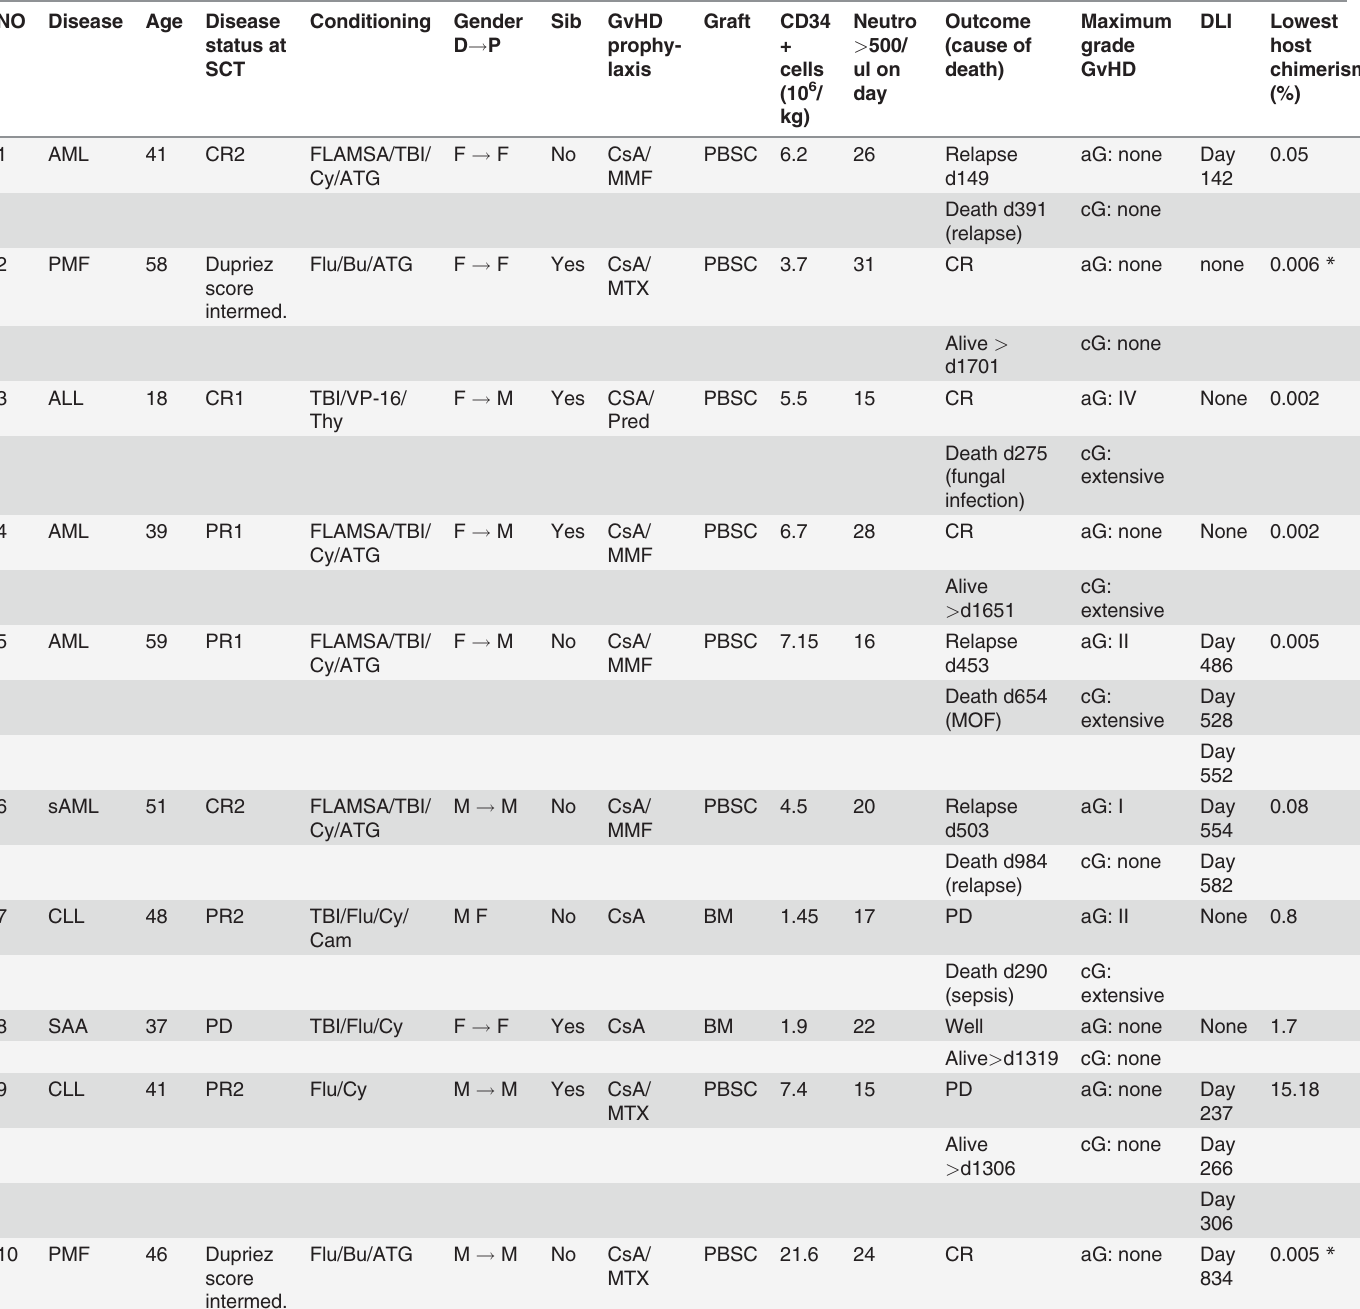
Table 1. Patient